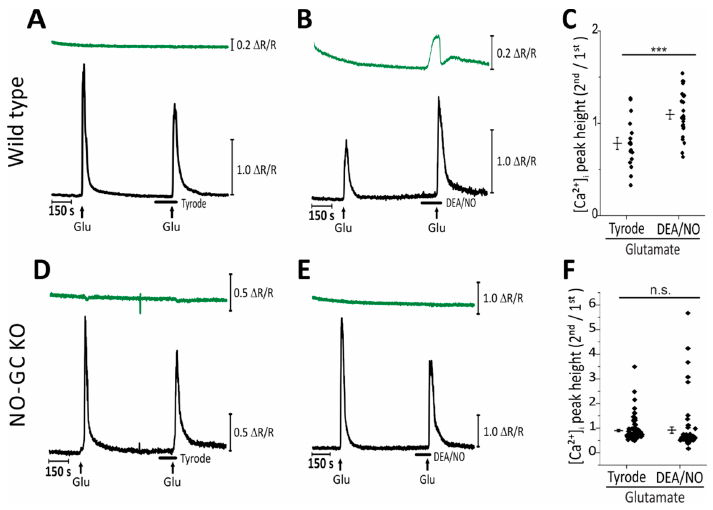
Figure 2. Simultaneous measurement of cGMP and Ca 2+ revealed cGMP–Ca 2+ crosstalk in CGNs. Traces depict cGMP (green) visualized with the cGi500 sensor, and [Ca 2+ ] i (black) visualized with Fura-2. CGNs were exposed to glutamate (100 µM) (for 10 s, represented by vertical arrows) to elevate [Ca 2+ ] i , and to DEA/NO (100 nM) (represented by horizontal bars) to increase the cGMP concentration. Tyrode buffer was used as a control in the absence of DEA/NO. Traces depict representative measurements of individual cells. Scale bars represent the change in fluorophore ratio ( Δ R/R reflecting [cGMP] or [Ca 2+ ] i ). ( A – C ) Imaging of cGi500-expressing CGNs with NO-GC wild type alleles (wild type). ( A ) Brief repetitive stimulation with glutamate under control conditions. ( B ) CGNs were exposed to